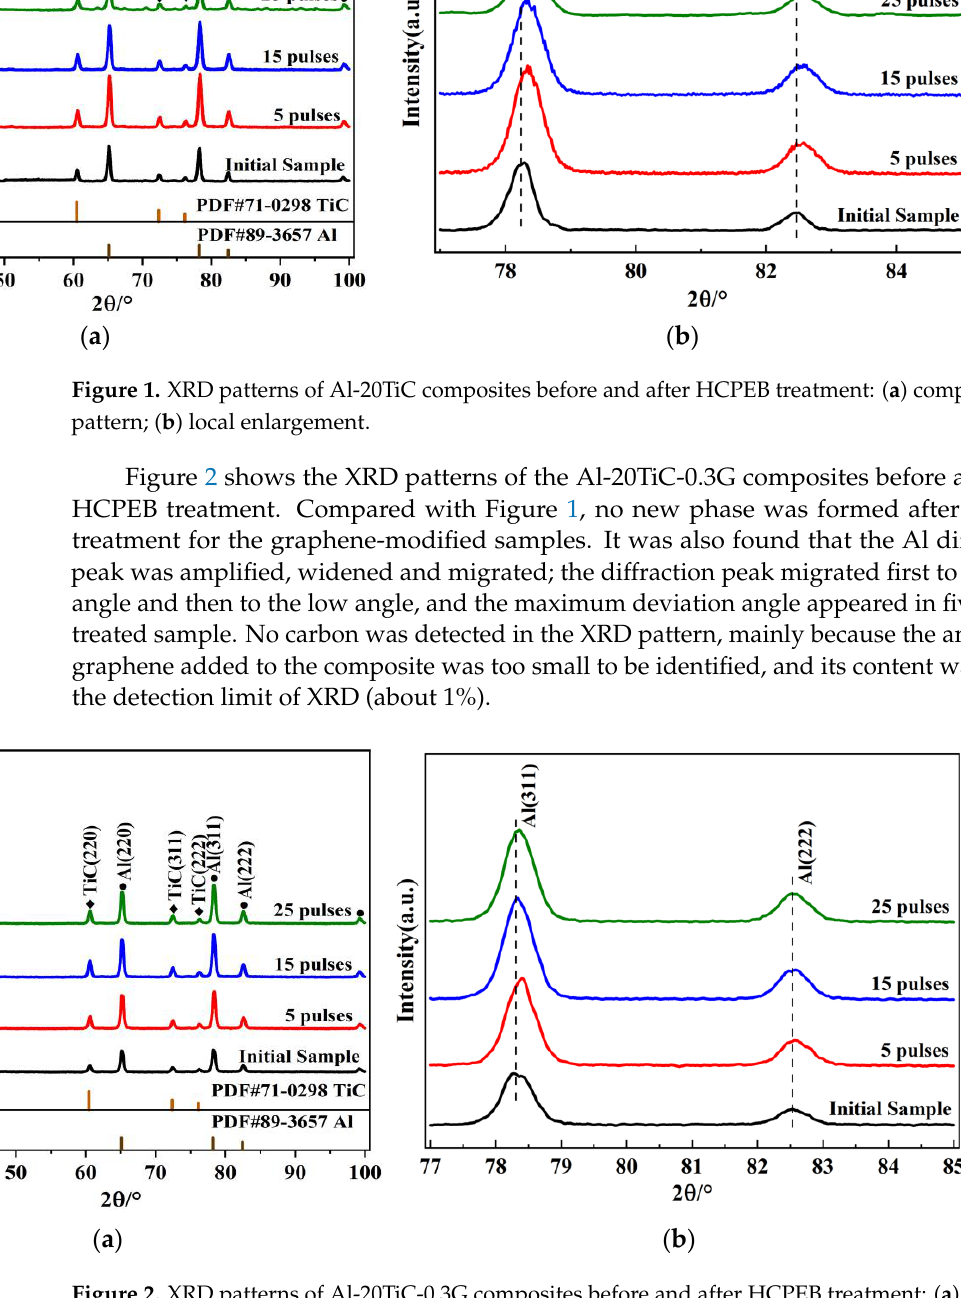
Figure 2. XRD patterns of Al-20TiC-0.3G composites before and after HCPEB treatment: ( a ) complete XRD pattern; ( b ) local